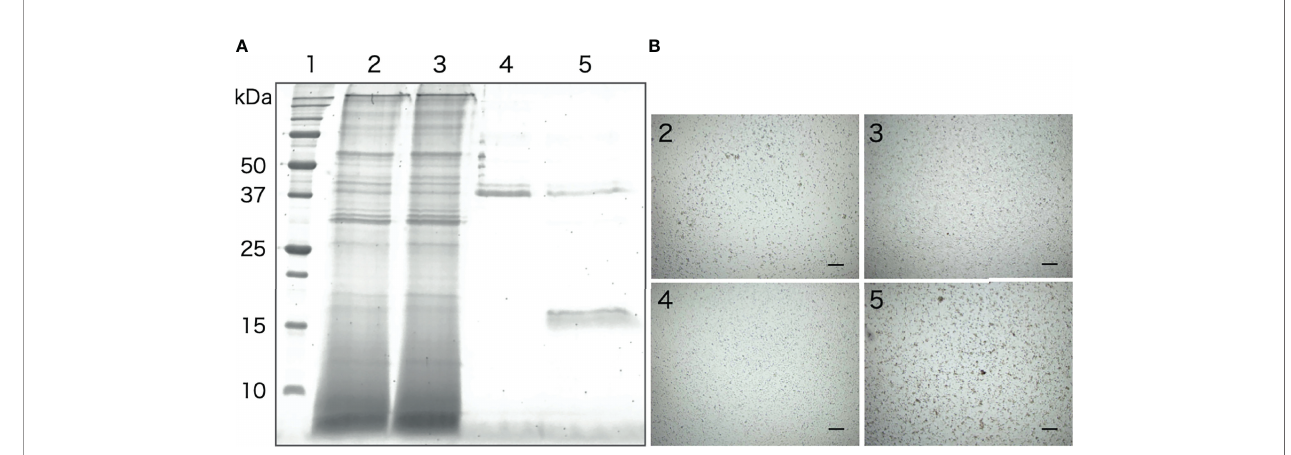
FIGURE 8 | Puri fi cation of the aggregation-promoting factor from the intestinal extract by galactose-af fi nity chromatography. (A) SDS-PAGE. Lanes: 1, molecular mass maker; 2, Intestinal extract; 3, non-adsorbed; 4, rinse-off; 5, galactose-binding protein. (B) Aggregation-promoting effects of each fraction. The numbers on the panels correspond to the number of the lanes in Figure 7A .Microscopic observation. Scale bars = 200 m